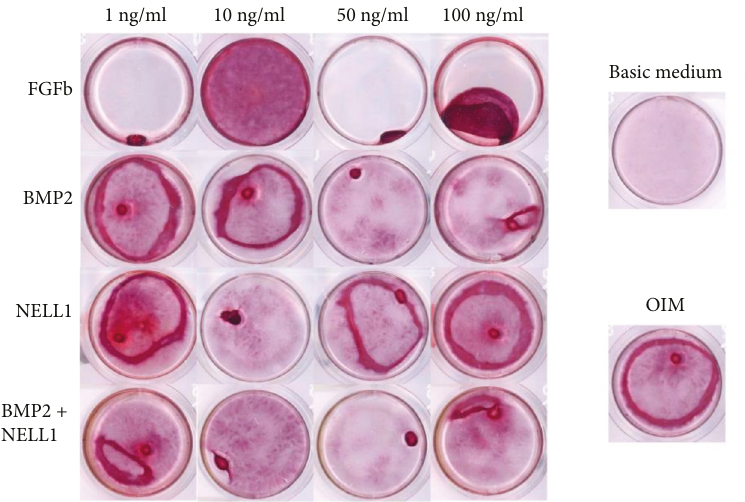
Figure 3: Alizarin red staining of oADSCs after a 14-day growth period in di ff erent growth mediums. Triplicates were made in all groups, and the most representative well from each group was chosen for the fi gure. The 4 × 4 square table is rhFGFb, rhBMP2, rhNELL1, and rhBMP2 plus rhNELL1 in di ff erent dosages with osteogenic induction medium (OIM). On the right the two controls: basic medium alone and OIM alone.